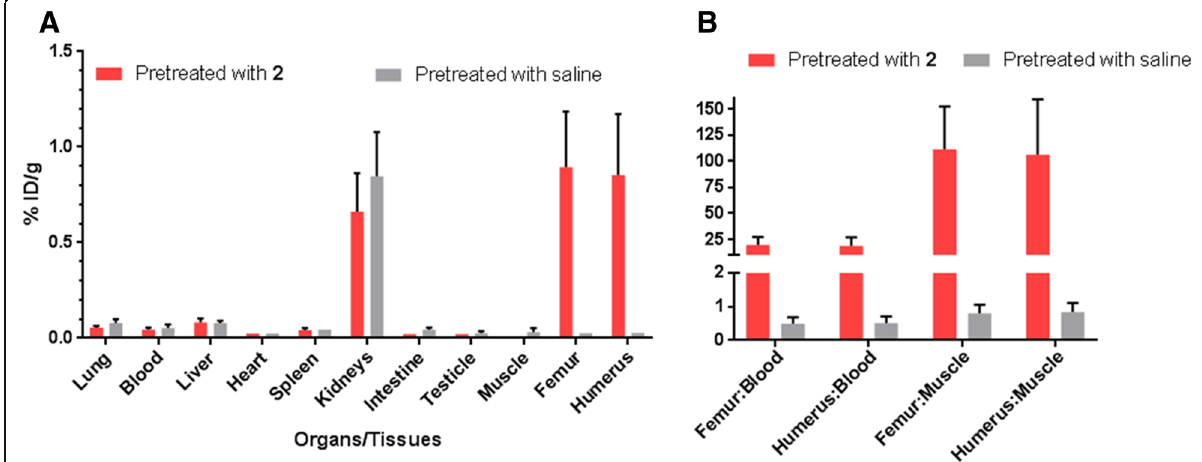
Fig. 3 Uptake values of [ 44 Sc] 3 in Wistar rats. a Ex vivo biodistribution 4 h p.i. of rats pre-treated with 2 or saline 1 h prior to administering 9 – 12 MBq of [ 44 Sc] 3 . b Select bone soft tissue ratio of [ 44 Sc] 3 in rats pre-treated with 1 or